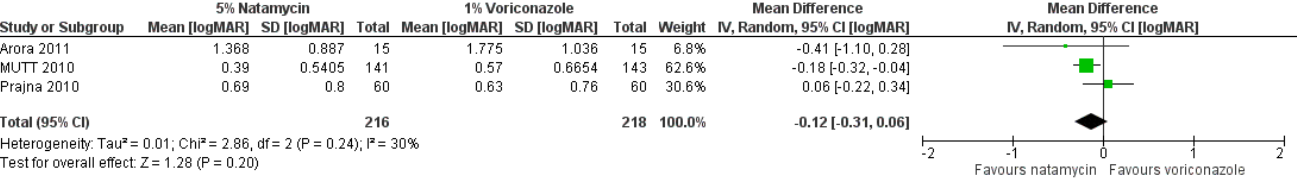
Figure 1. Forest plot of topical natamycin 5% versus voriconazole 1% (outcome: best spectacle corrected visual acuity, logMAR). Reproduced from FlorCruz NV, Evans JR. Medical interventions for fungal keratitis. The Cochrane Database of Systematic Reviews 2015; 4 : CD004241 with permission from John Wiley and Sons [5].